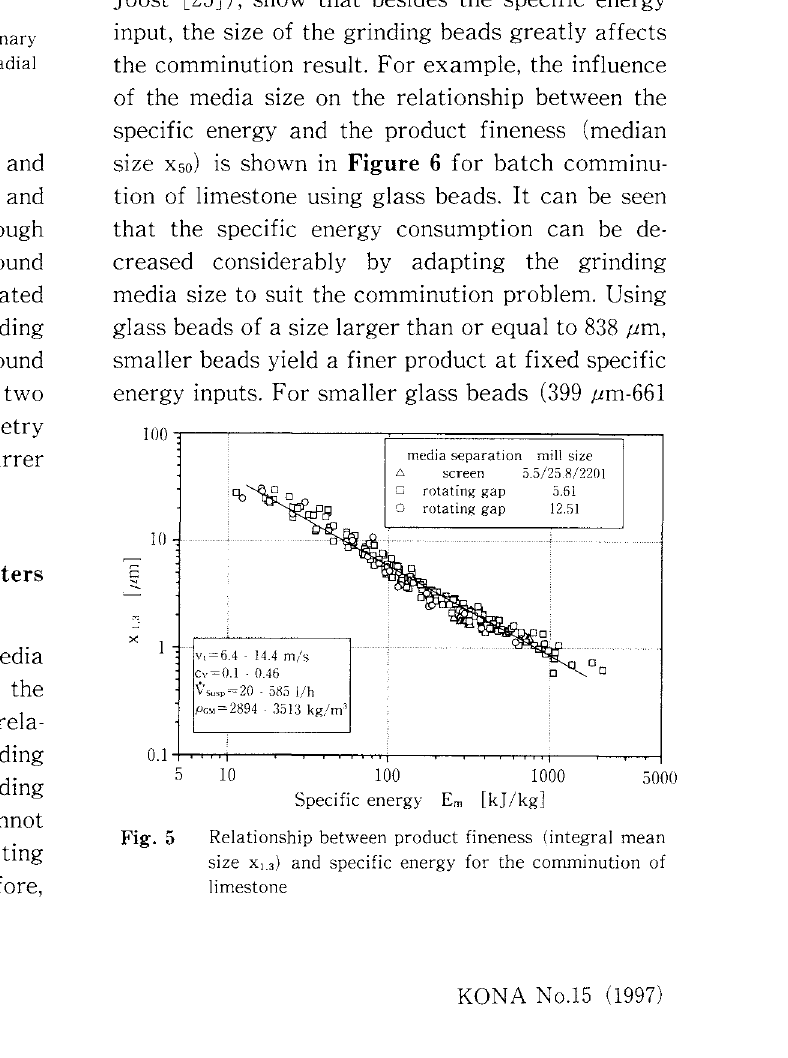
Fig. 4 Profiles of the tangential fluid velocity and stationary trajectories of single grinding beads in the axial-radial plane [8,9] density.